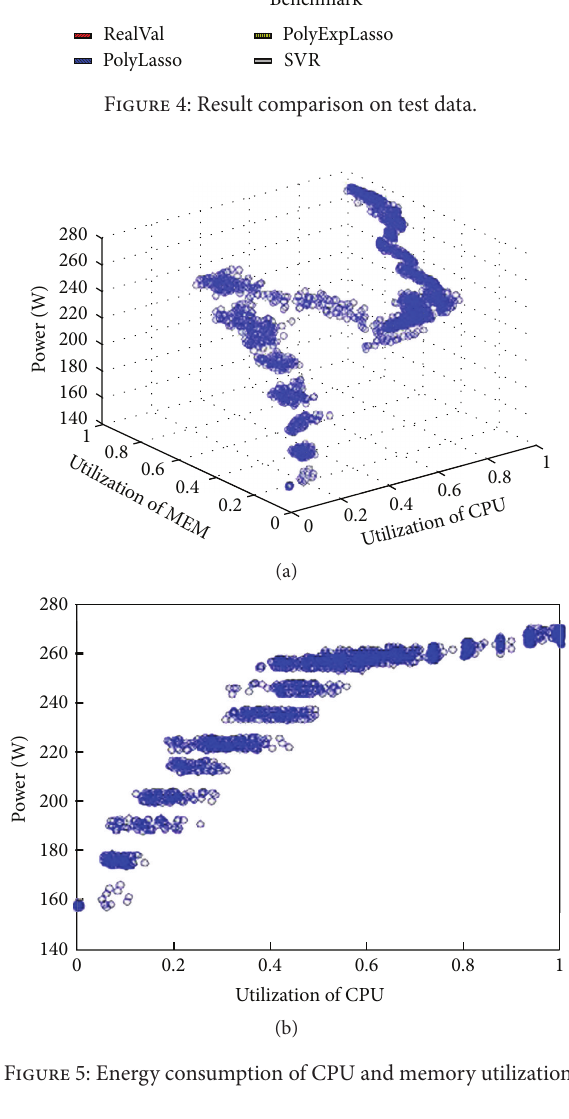
Figure 5: Energy consumption of CPU and memory